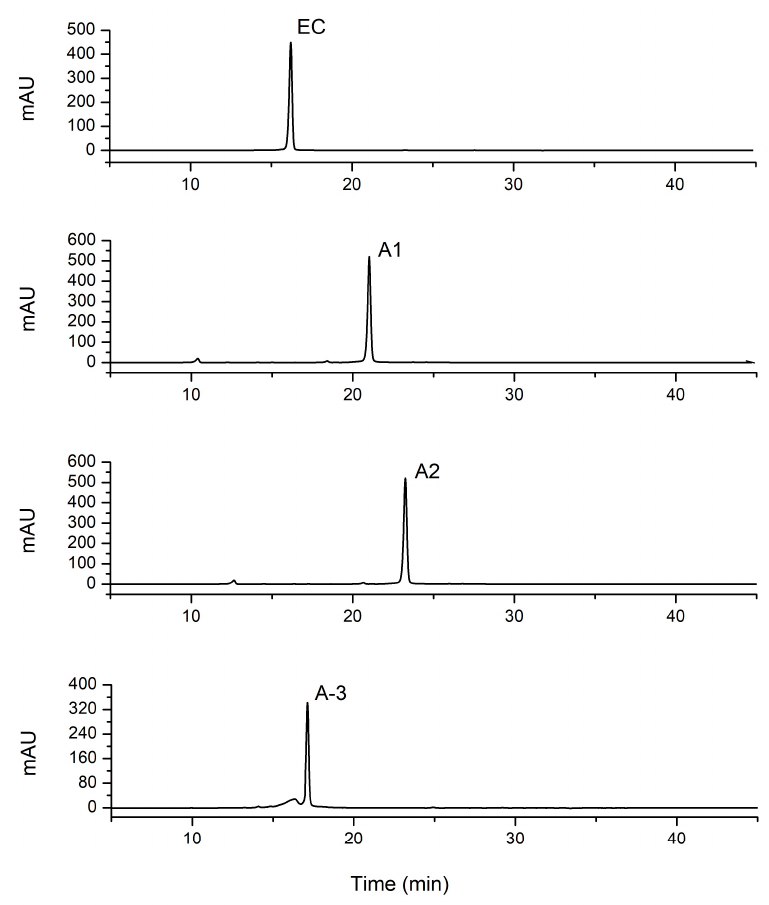
Figure 3. Specific chromatograms of EC, A1, A2, and A-3 standard by HPLC analysis.